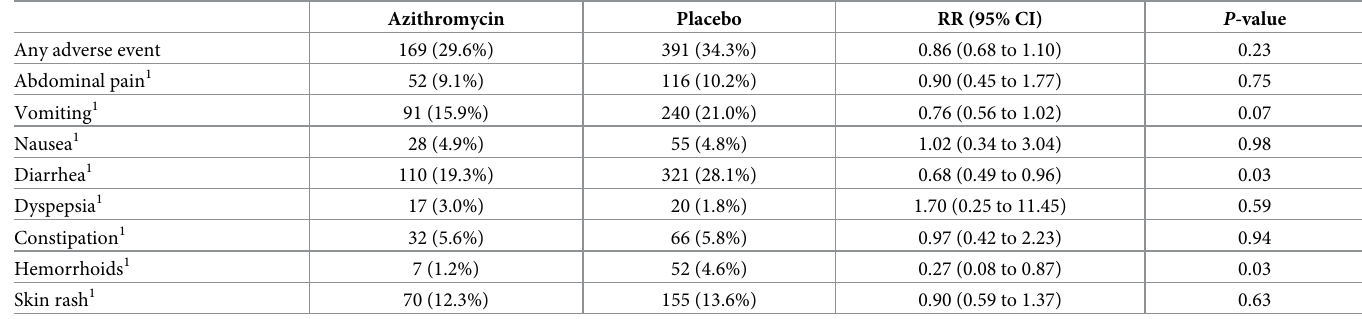
Table 3. Adverse events following azithromycin treatment among infants aged 1–5 months in communities randomized to azithromycin or placebo (N =